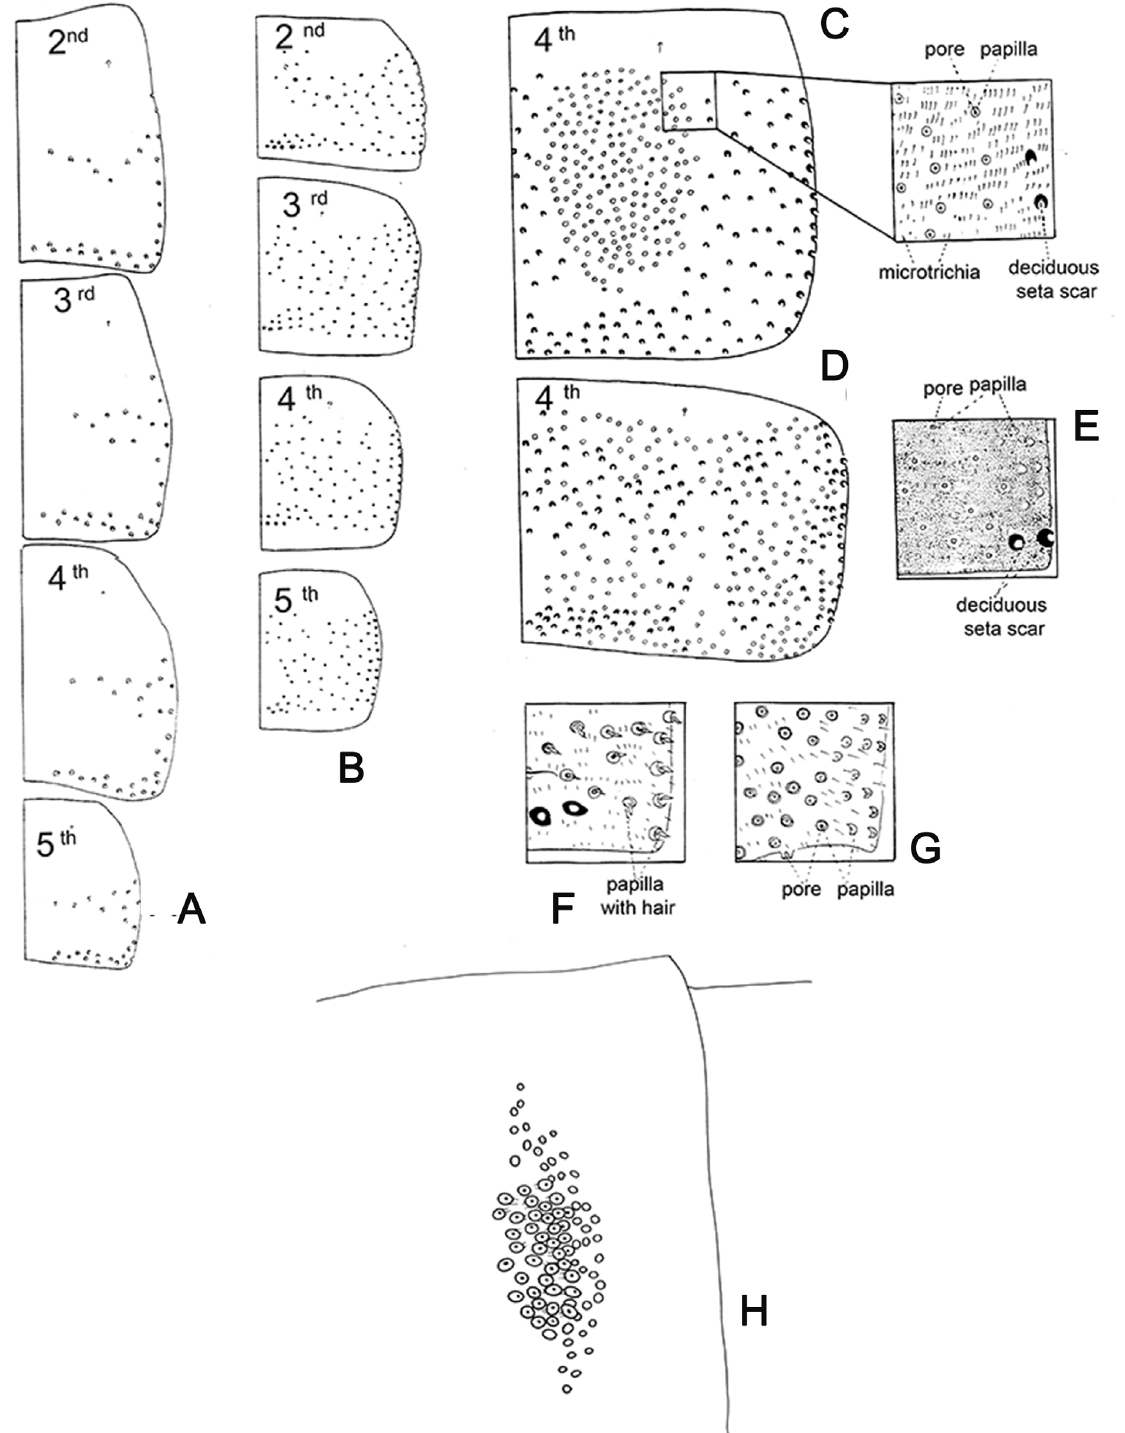
Figure 15. Abdominal tergites of Phlebotominae, showing arrangements of the deciduous bristles and tergal papillae and aspects of the tergal papillae and ‘‘trumpets glands’’. (A, B) 2nd–5th male tergites with the arrangement of the deciduous bristles. (A) Two transverse bands: Warileya phlebotomanica . (B) Randomly: Nyssomyia intermedia . (C, D) Distribution and aspects of the tergal papillae on 4th tergite; (C) restricted to the central area: Lutzomyia longipalpis ; (D) dispersed over the surface of the tergite, among the deciduous bristle scars: Pintomyia fischeri . (E–G) Aspects of the papillae on the 6th tergite: (E) papillae without hair and without clear demarcation of their borders; (F) papillae with hair: Brumptomyia cardosoi ; (G) papillae without hair and with clear demarcation of their borders: Evandromyia walkeri . (H) ‘‘Trumpet glands’’ of the fourth abdominal tergite: Chinius samarensis